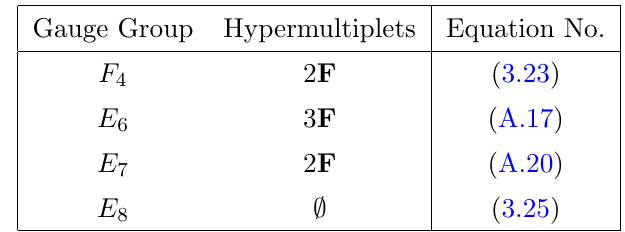
Table 3 . Character expansion of exceptional gauge theory with fundamental